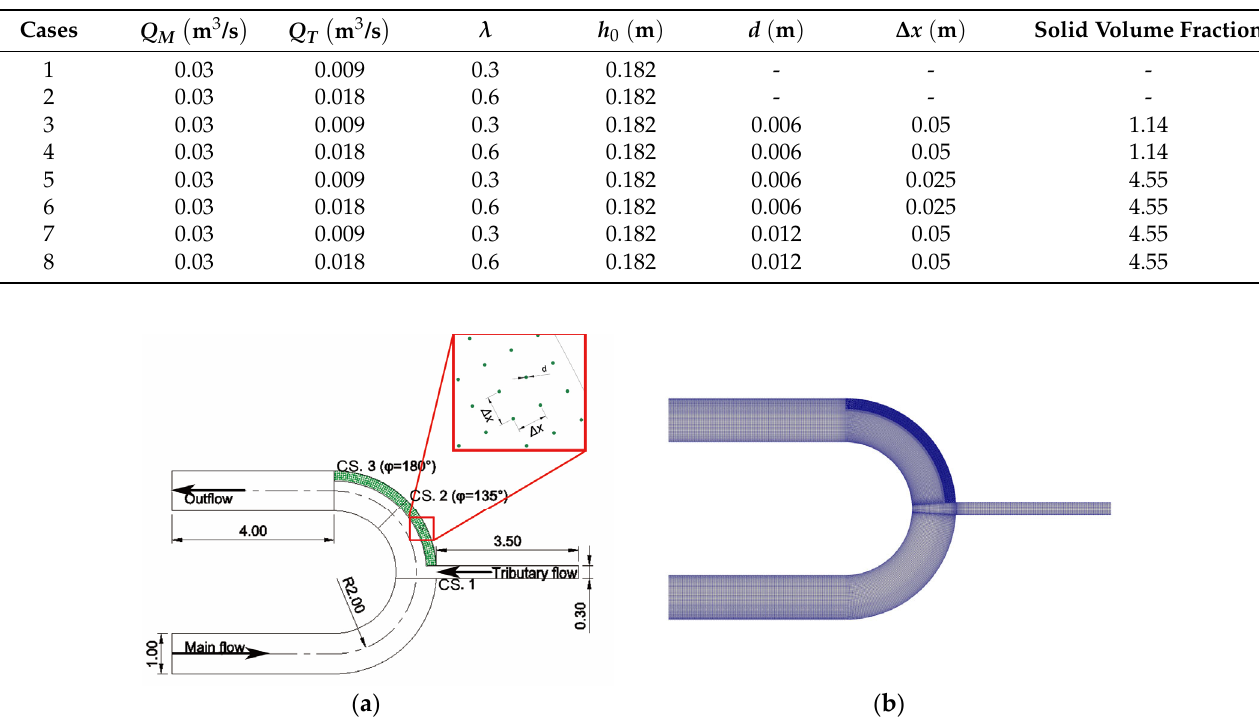
Figure 8. ( a ) The schematic of a U ‐ shape open ‐ channel with a tributary and an emergent rigid veg ‐ etation region on the concave bank and the detailed view of the vegetation region (units: m); ( b ) The local refined calculating